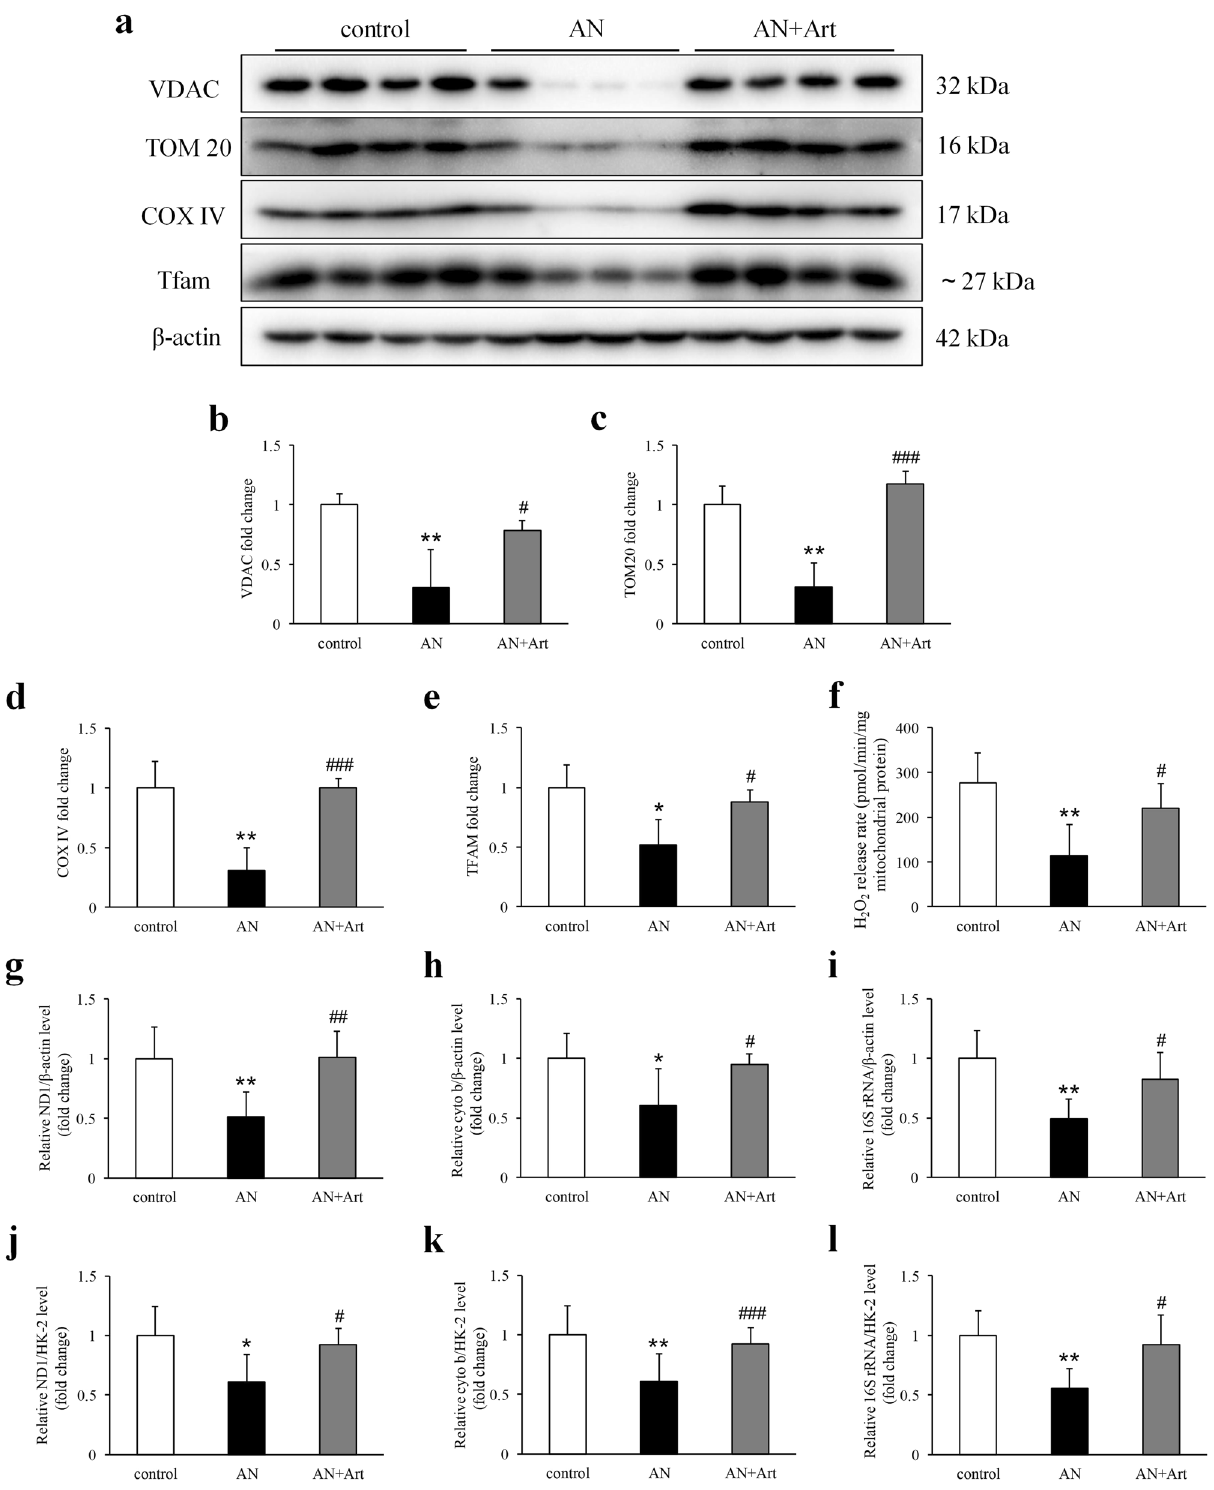
Figure 7. Artemether increased mitochondrial mass and improved mitochondrial function. ( a – e ) Western blot images and quantitative analysis of VDAC, TOM20, COX IV, and Tfam in renal tissue of various groups. n = 4 per group. ( f ) Mitochondrial H 2 O 2 release rate in each group after artemether treatment for 2 weeks. n = 6 per group. ( g – l ) Bar graphs indicating the quantification of mitochondrial DNA copy number (determined by qPCR for ND1, cytochrome b, and 16S rRNA against β-actin and HK-2) in each group. n = 6 per group. * P < 0.05 and ** P < 0.01 versus control; # P < 0.05, ## P < 0.01 and ### P < 0.001 versus